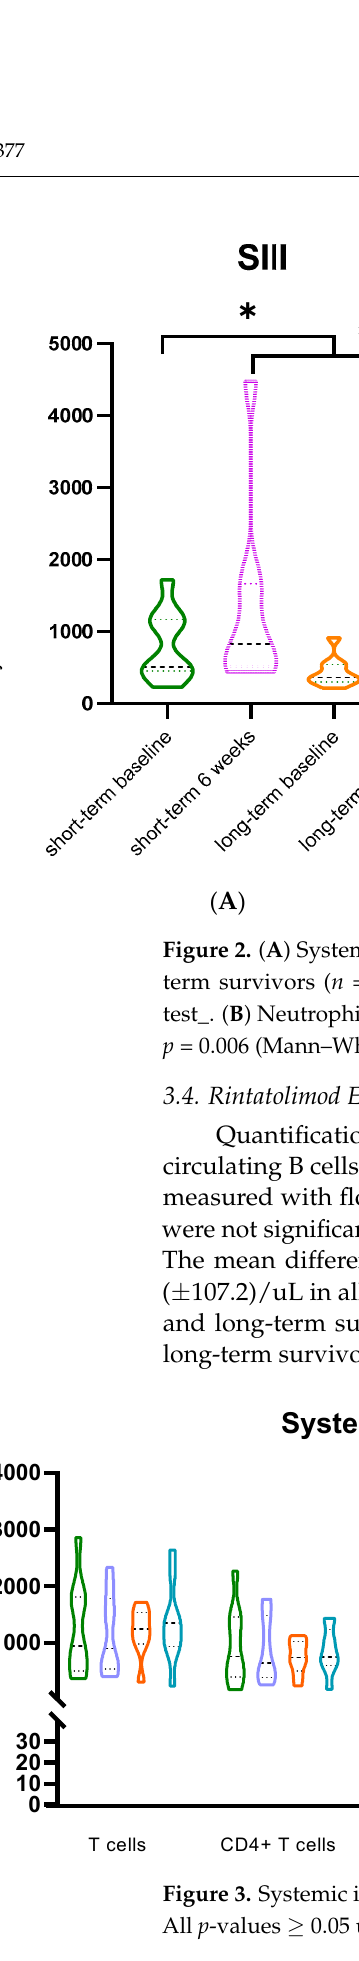
( B ) Figure 4. ( A ) B cells in circulating blood of all patients treated with rintatolimod ( n = 18, *: p = 0.001 from paired sample t -test). ( B ) B cells in circulating blood of short-term survivors ( n = 9) and long- term survivors ( n = 9 *: p = 0.002 from paired sample t -test). 3.5. Rintatolimod Treatment Associate with Extended Progression-Free and Overall Survival All groups (rintatolimod treatment group ( n = 27), matched controls ( n = 54) and sub- set of matched controls ( n = 27)) were comparable with regard to age, sex, disease stage, and number of FOLFIRINOX cycles (Table 2). Most of the patients in all groups were males in the metastatic disease stage. The median number of FOLFIRINOX cycles was 8.0. The total matched control group was incomparable to the rintatolimod group in terms of progression-free intervals before the start of treatment with rintatolimod (Table 2). The matched controls had a significantly shorter median progression-free interval calculated